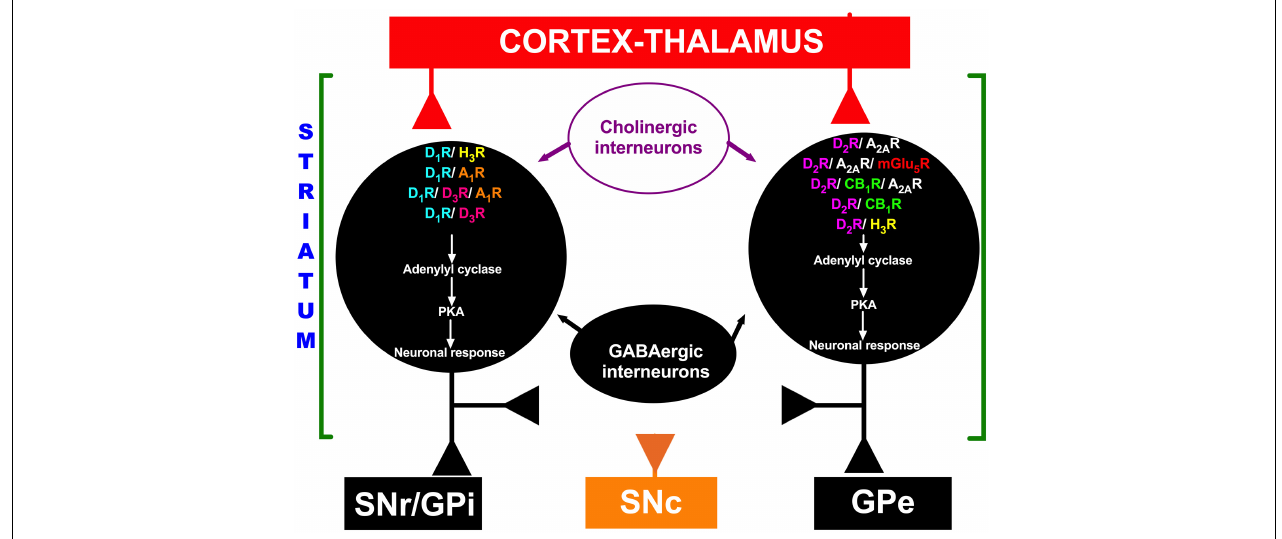
FIGURE 3 | Schematic representation of functional interactions between DA receptors and other heteroreceptors localized in medium spiny neurons (MSNs). Red indicates excitatory projections, and black indicates inhibitory projections. In the striatum, GABAergic MSNs communicate with neurons in the substantia nigra pars reticulata (SNr) or internal segment of the globus pallidus (GPi) through a direct pathway and to the external segment of the globus pallidus (GPe); the GPe in turn projects to the subthalamic nucleus (STN), which projects to the SNr, forming the indirect pathway. The orange color represents the substantia nigra pars compacta (SNc). D 1 R, D 1 receptor; D 2 R, D 2 receptor; A 1 R, A 1 receptor; A 2 R, A 2 receptor; H 3 R, H 3 receptor; D 3 R, D 3 receptor; mGlu 5 R, mGlu 5 receptor; CB 1 R, CB 1 receptor; PKA, protein kinase